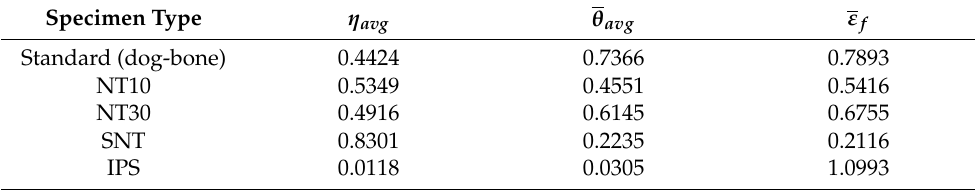
Table 3. Loading parameters and equivalent strain at fracture for different types of